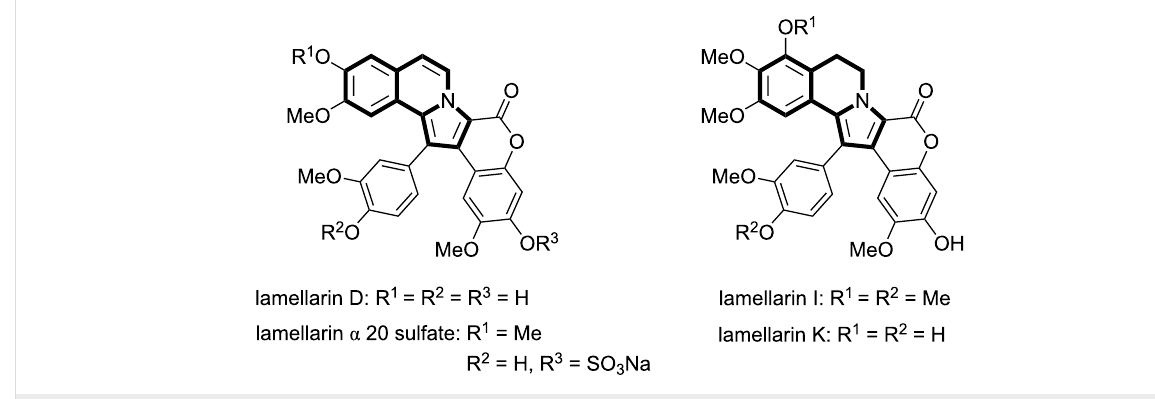
Figure 1: Representative examples of lamellarin alkaloids.